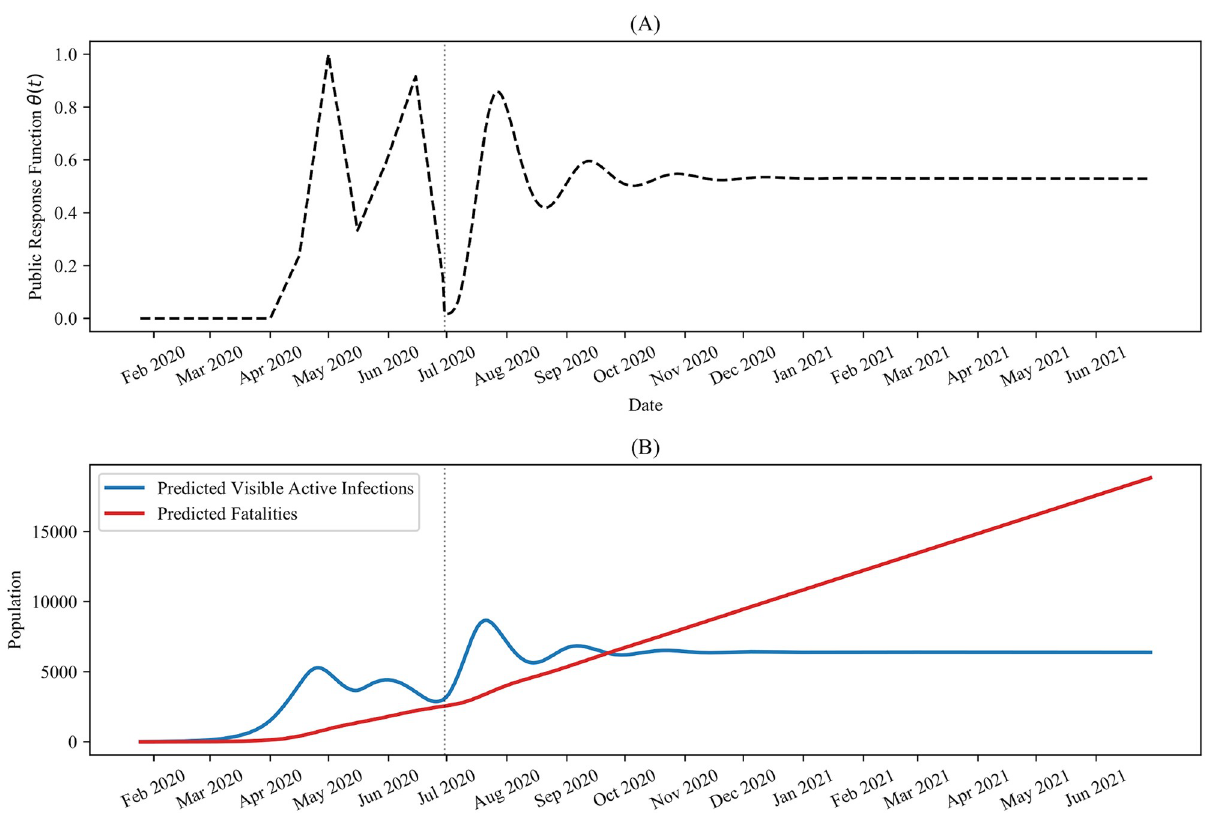
Fig 8. Predicted pandemic progression for time-lag dependent public-response. Predicted future pandemic progression, obtained by assuming a linear dependence of θ ( t ) on I ( t − 6). (A) Response function θ ( t ) determined by linear regression, (B) The corresponding active visible infections and fatalities, predicted by the Distancing-SEIRD model with the parameter values in Table 1. In both panels, the dotted vertical line indicates τ 7 = t 30, 2020.